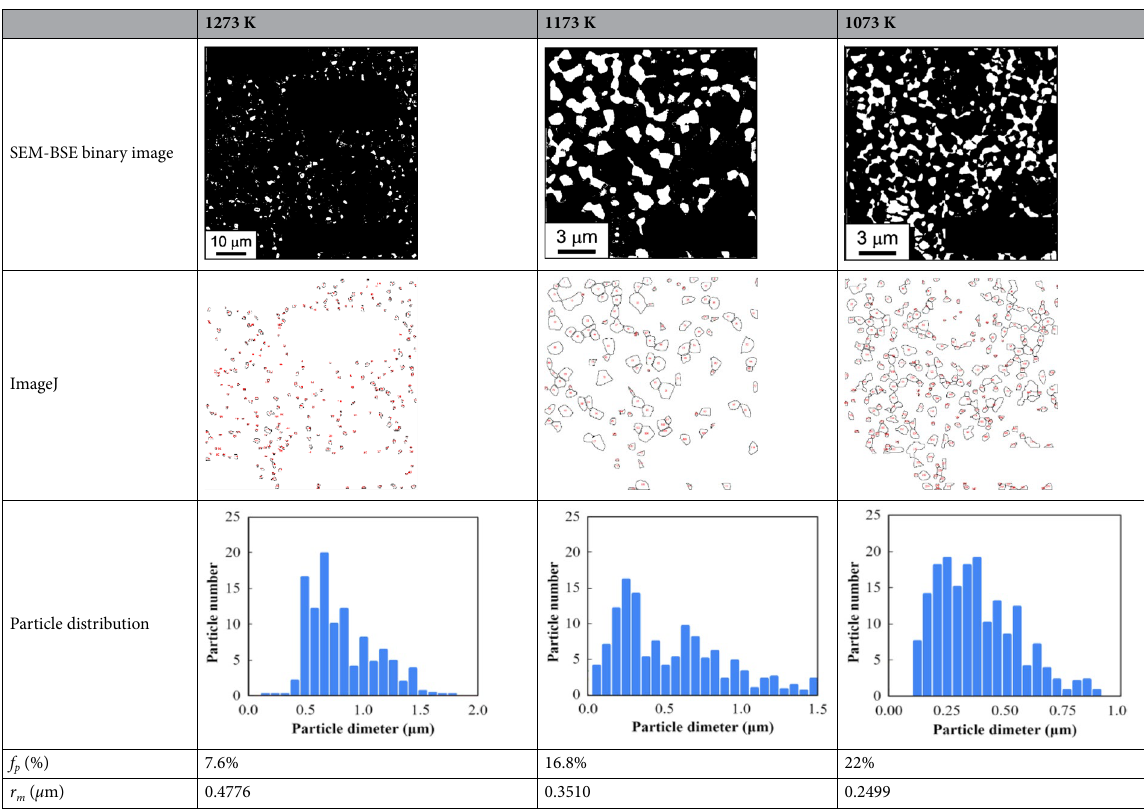
Table 1. Post-processing of experimental data (ImageJ